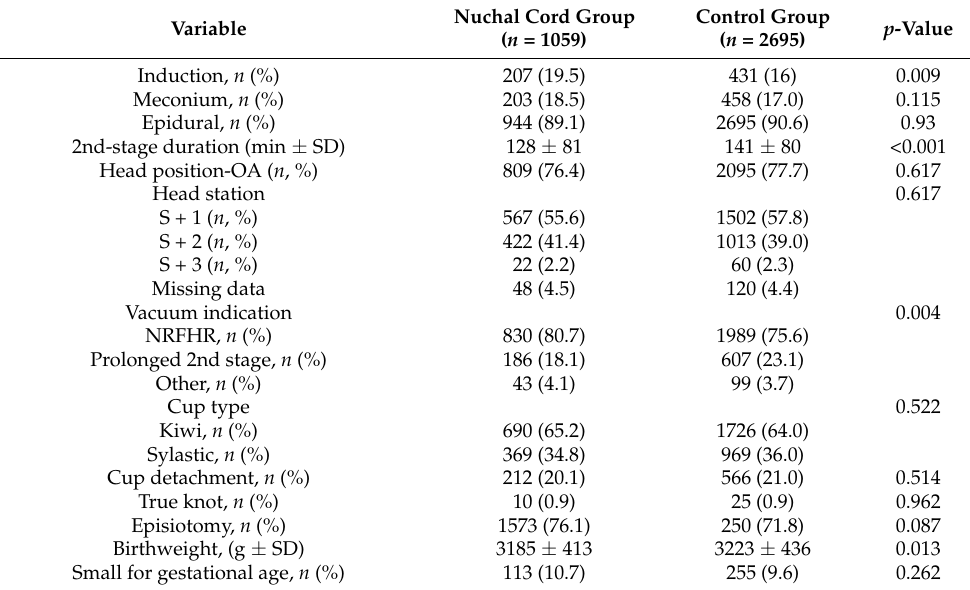
Table 2. Labor and delivery characteristics in relation to nuchal cord.